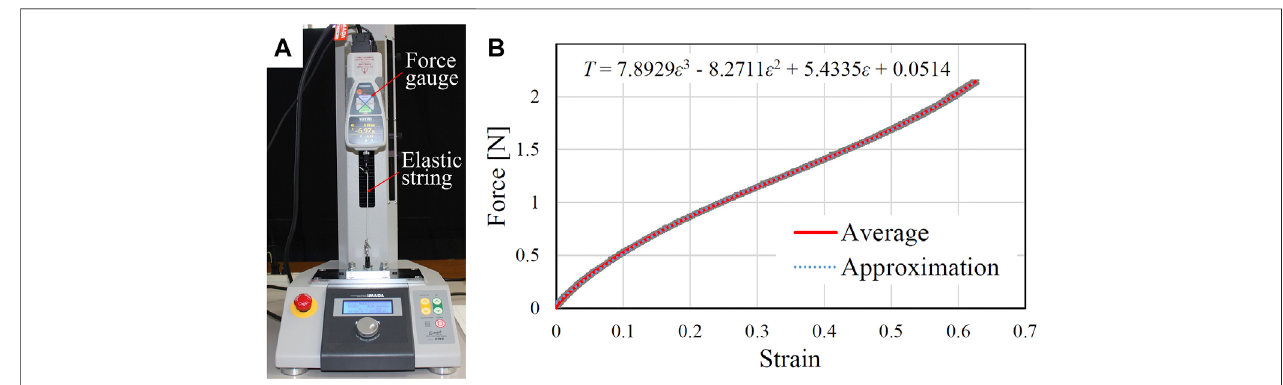
shown in Figure 6A . The string was fi xed between the end of the force gauge and the test stand. The force gauge was slowly translated upward with a velocity of 60 mm/s to extend the string. The tension force was recorded by the force gauge. Five